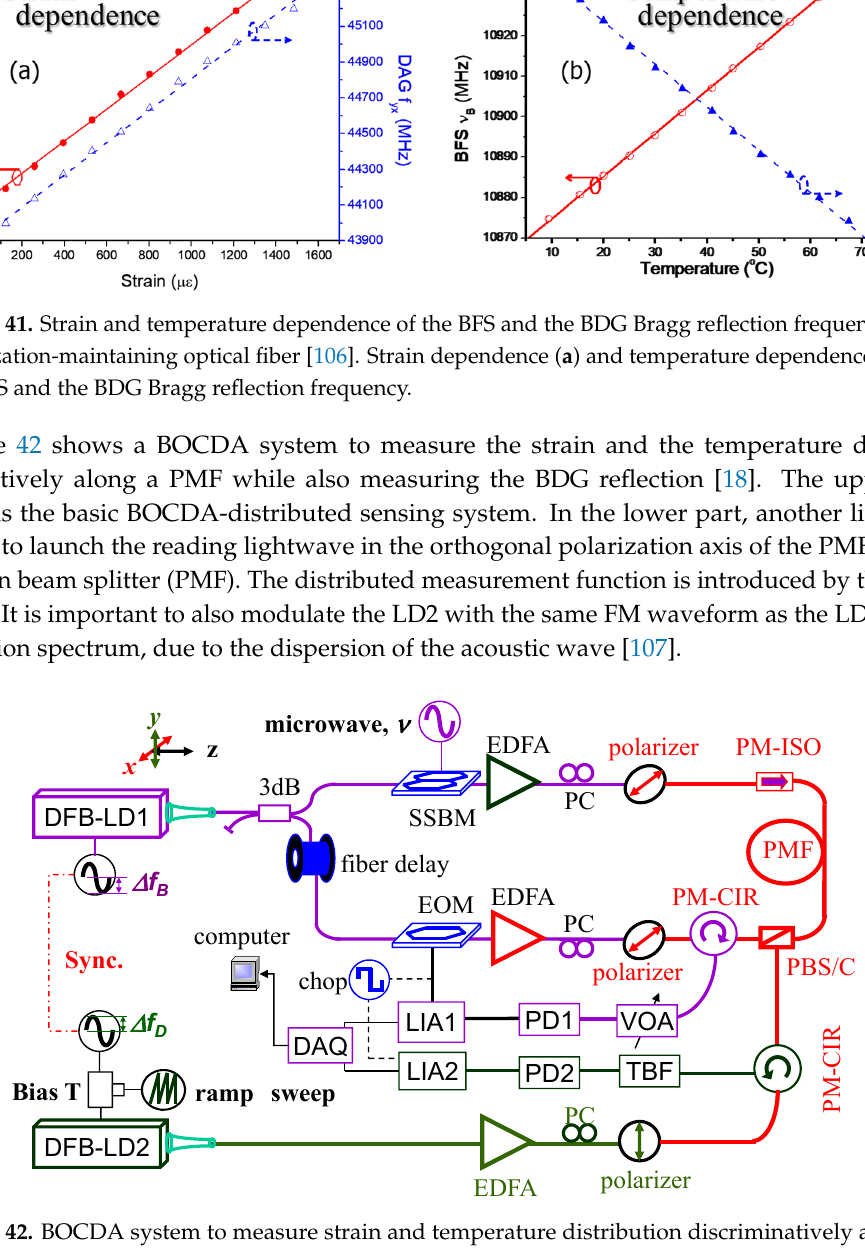
Figure 41. Strain and temperature dependence of the BFS and the BDG Bragg reflection frequency in a polarization-maintaining optical fiber [106]. Strain dependence (a) and temperature dependence (b) of the BFS and the BDG Bragg reflection frequency.